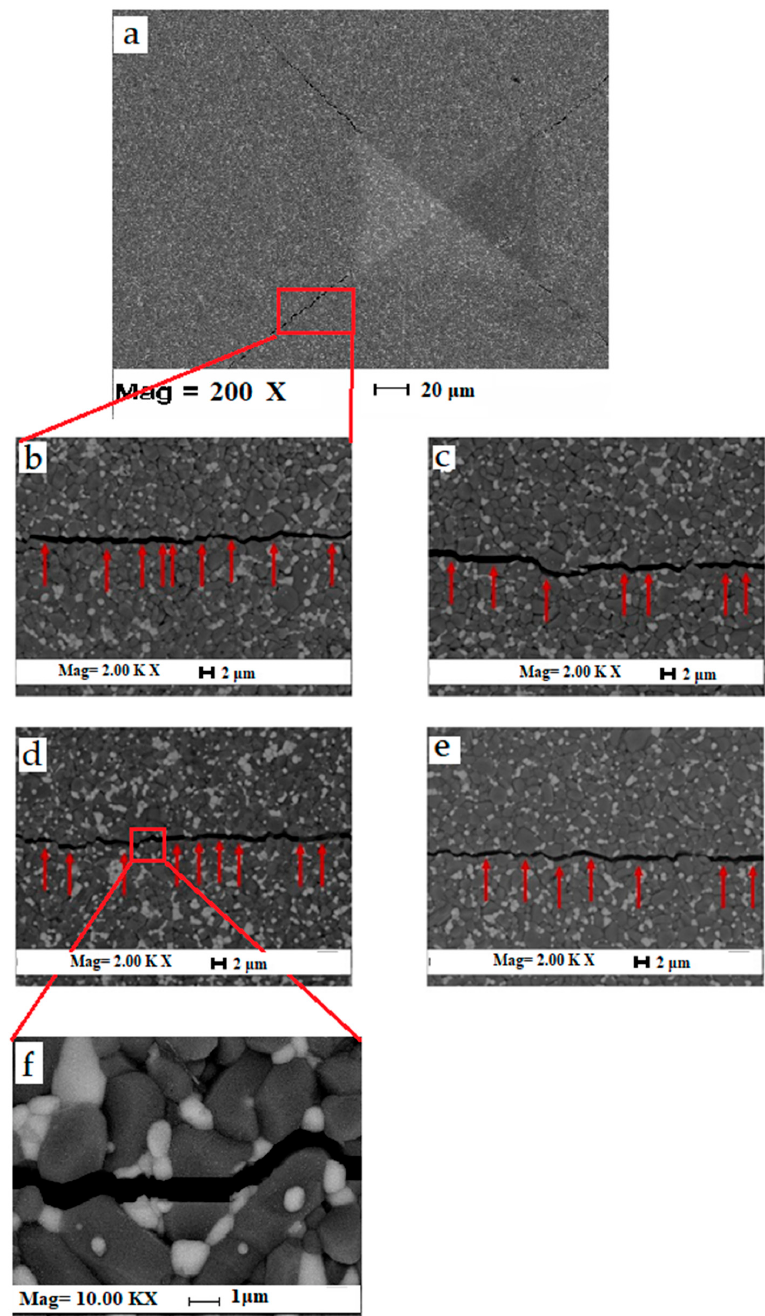
Figure 6. Crack propagation of ZTA-MgO samples. ( a ) Cracks at tips of Vickers hardness indent tips ( b ) 0.2 wt.% MgO, ( c ) 0.5 wt.% MgO, ( d ) 0.7 wt.% MgO, ( e ) 0.9 wt.% MgO and ( f ) high magnification of